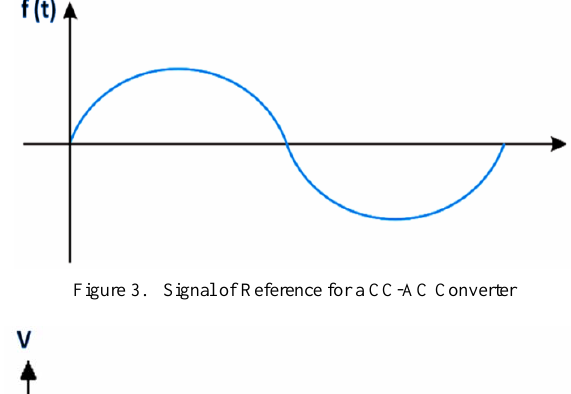
Figure 2. Signal of Reference for a CC-CC converter